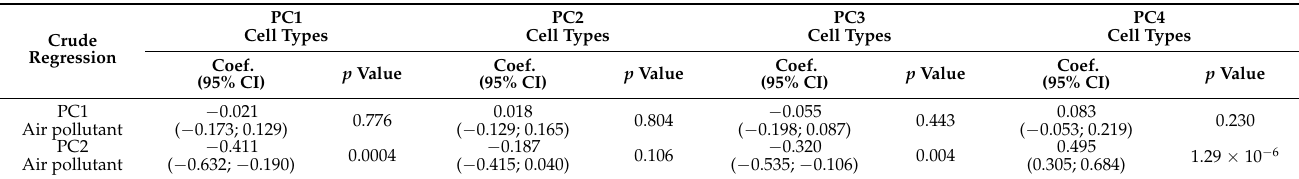
Table 4. Crude regression model of PCs of air pollutants and cord blood cell types. After Bonferroni correction, significance was considered when p <